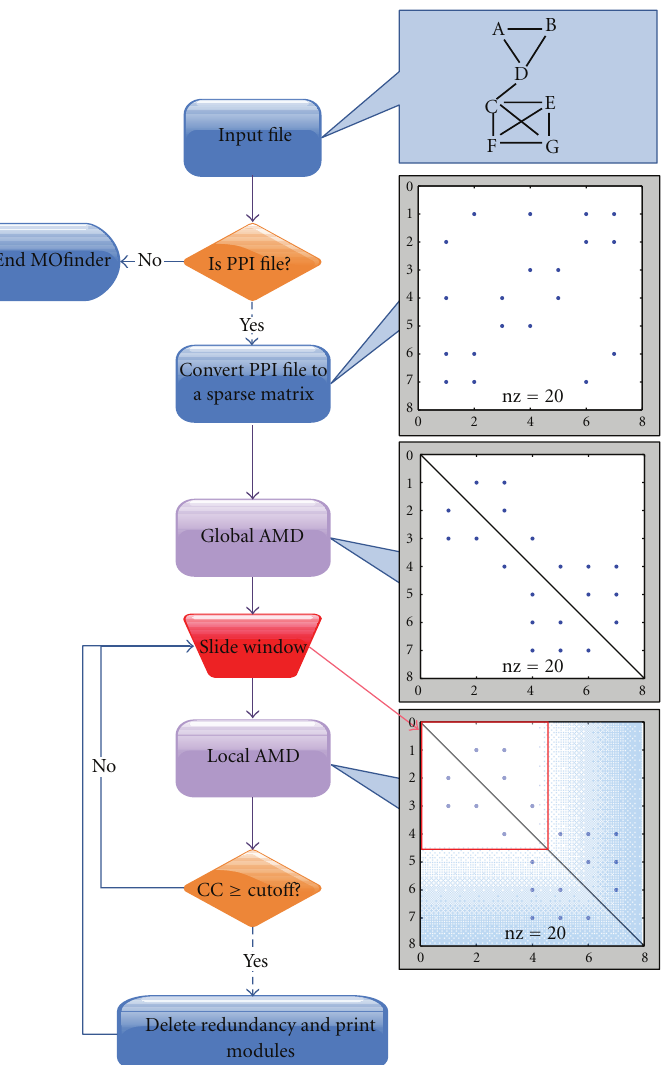
Figure 1: The flowchart of the MOfinder. MOfinder first converts the PPI file into a sparse matrix and then performs the global AMD. Next, the MOfinder fetches the local submatrix using a sliding window and also performs the local AMD. The CC value of the submatrix is calculated. At last, submatrixes with CC value < cut-o ff are filtered and redundant modules are removed; others are saved as modules.